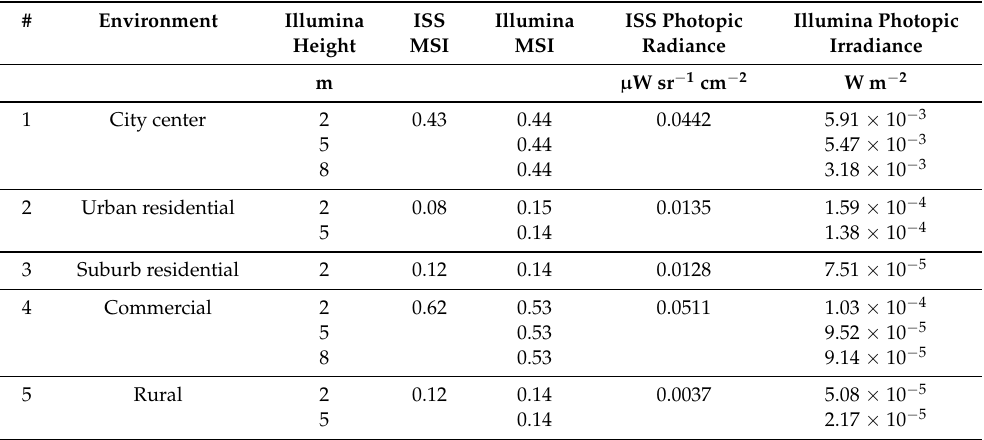
Table 4. Comparative results for the identified sites. Illumina MSI and Illumina photopic irradiance are the results obtained with Illumina v2, while ISS MSI and ISS photopic radiance are the values derived from the ISS